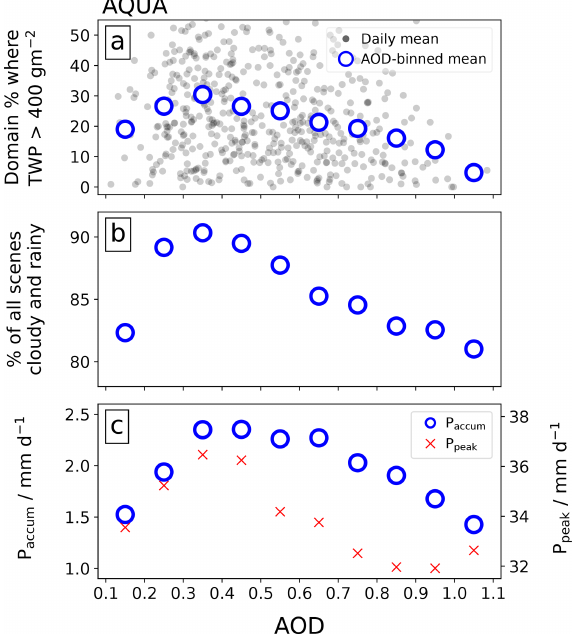
Figure 3. Convection and precipitation as a function of AOD: (a) percentage of the domain where TWP > 400gm − 2 as a func- tion of the domain mean AOD for each day (filled grey circles) and the mean of all days binned by AOD (empty blue circles), (b) mean percentage of all scenes that include liquid cloud and precipitation as a function of binned AOD, and (c) mean daily accumulated pre- cipitation (blue circles) and daily peak precipitation (red crosses) in each scene binned by AOD. MODIS data are shown for the AQUA